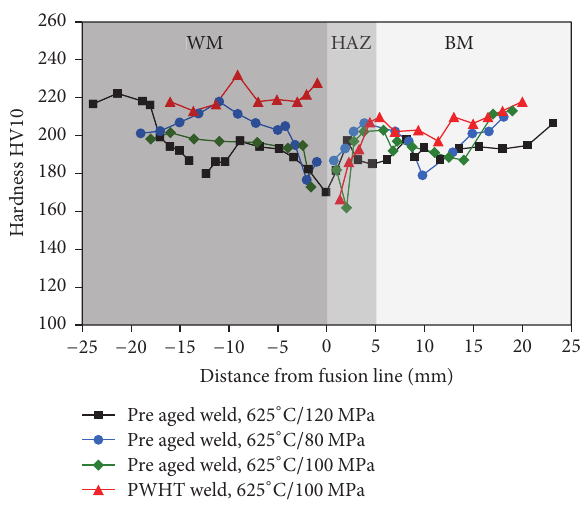
Figure 17: Cross-weld hardness profiles of several creep-exposed CB2 weldments.